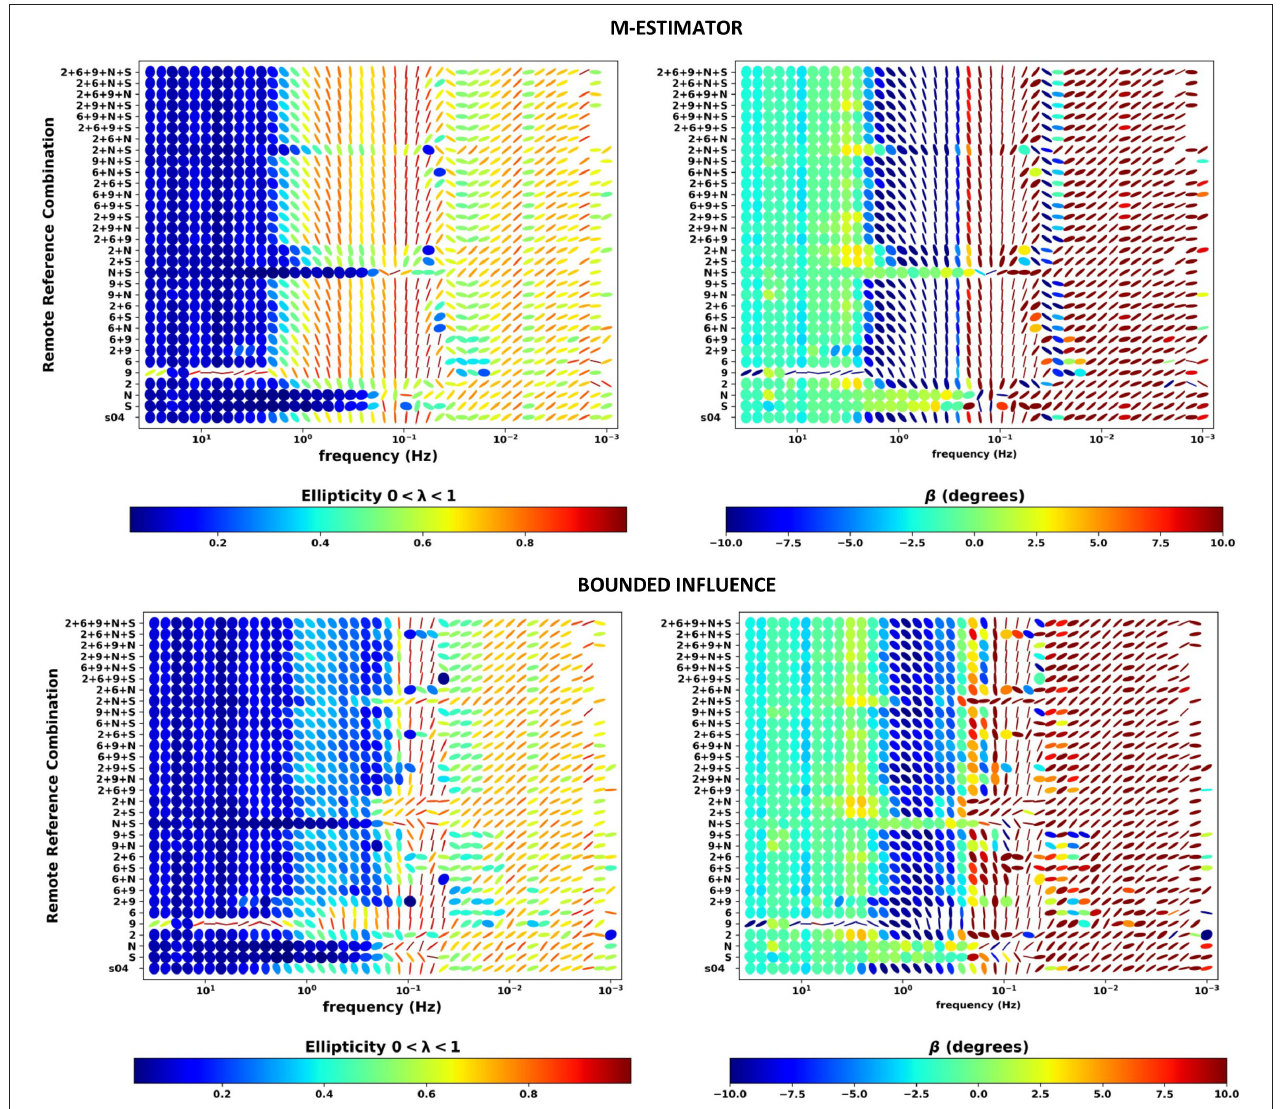
FIGURE 8 | Upper section: M-estimator results. Site 4 with local RRs 2, 6, and 9 and distant RRs Welschbruch (rr100) and Schwabwiller (rr99). Left: normalized phase tensor for all combinations of RR as a function frequency filled with their ellipticity λ value (1D indicator). Right: normalized phase tensors filled with β angle (2D indicator) value; the color bar is limited to [-10 ◦ 10 ◦ ] range. Lower section: bounded influence results. Same legend as